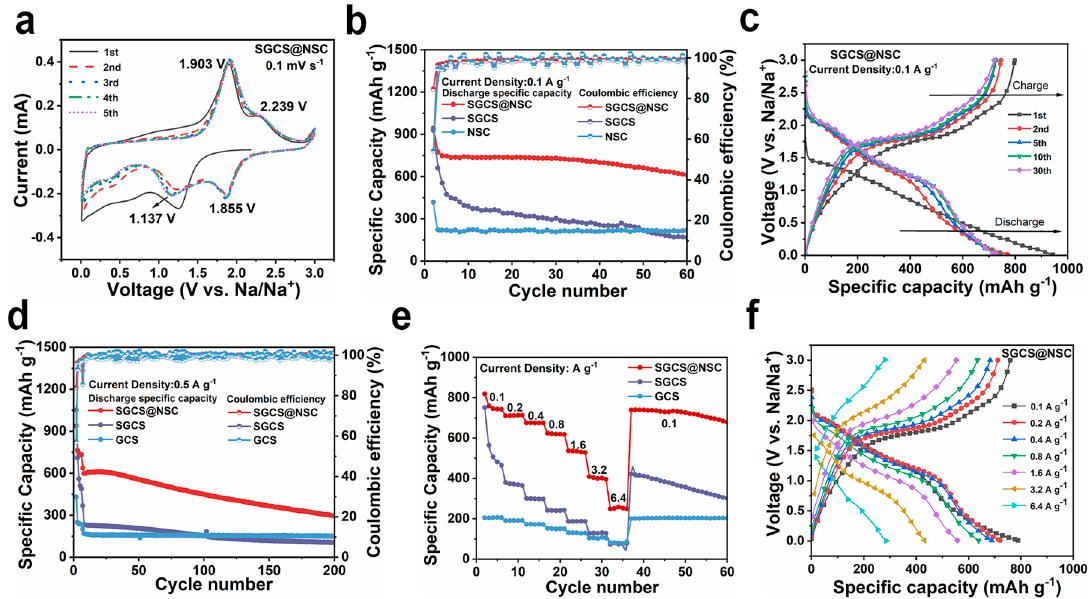
Figure 3. The electrochemical characterization of SGCS, SGCS@NSC, and NSC in the voltage range of 0.01–3.0 V versus Na/Na + . ( a ) The first five CV curves of SGCS@NSC at 0.1 mV s − 1 . ( b ) Cycling test at 0.1 A g − 1 . ( c ) The 1st, 2nd, 5th, 10th, and 30th cycles discharge–charge profiles of SGCS@NSC at 100 mA g − 1 . ( d ) Cycling test at 0.5 A g − 1 . ( e ) Rate capability electrodes at increasing current densities from 0.1 to 6.4 A g − 1 . ( f ) Galvanostatic discharge–charge profiles of SGCS@NSC at increasing current densities from 0.1 to 6.4 A g − 1 .